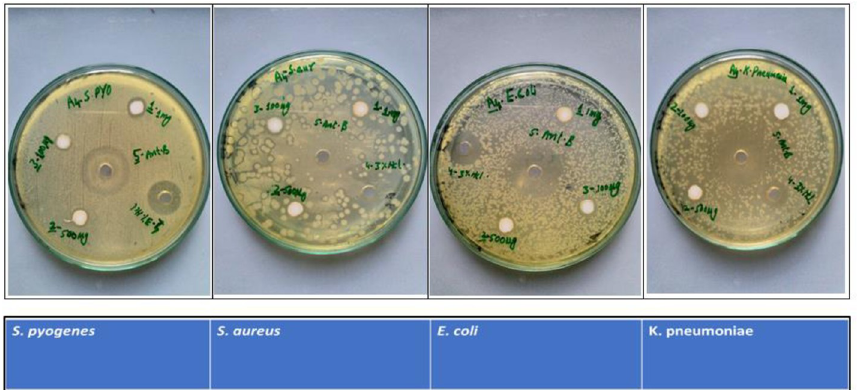
Fig 5. Zone of inhibition formed by ZnO-NPs against different